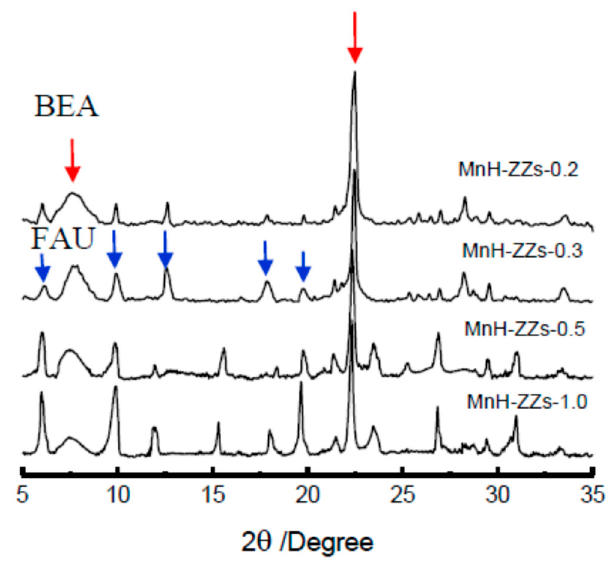
Figure 1. XRD patterns of MnH-ZZs-n (n = 1.0, 0.5, 0.3,